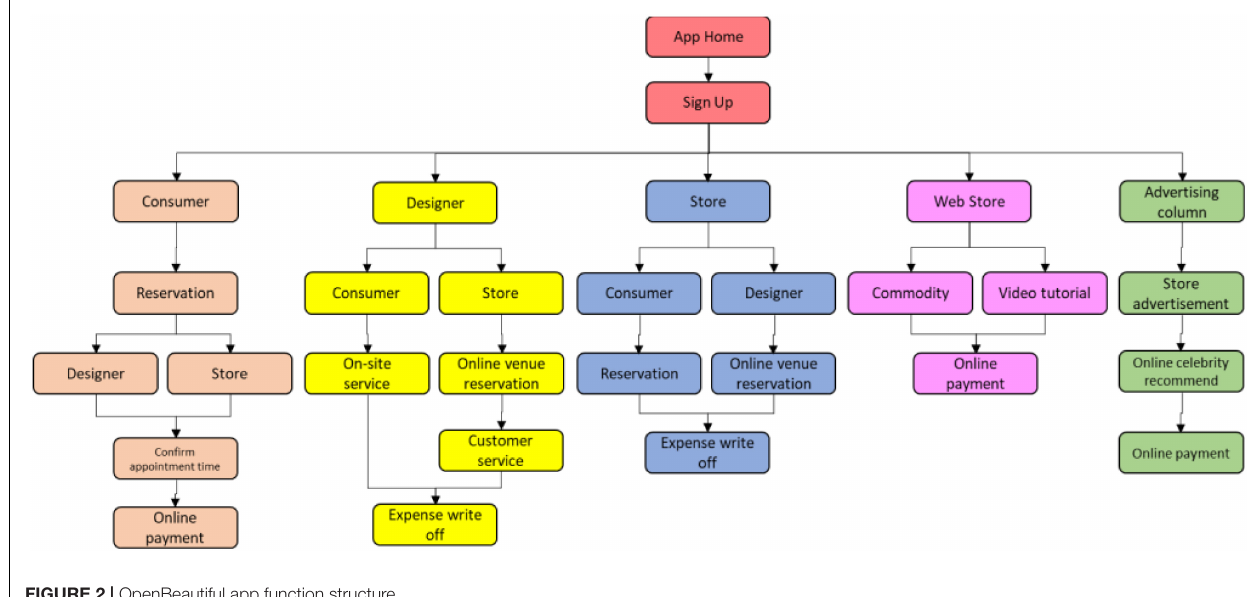
FIGURE 2 | OpenBeautiful app function structure.